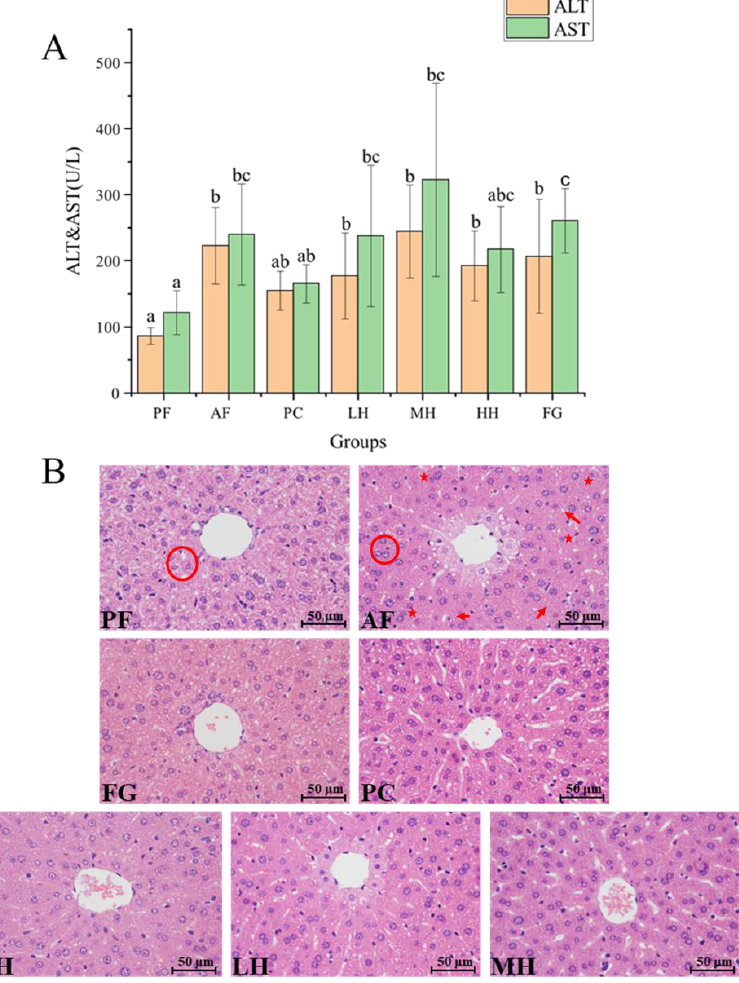
Figure 1. ( A ) Serum alanine aminotransferase (ALT) and aspartate aminotransferase (AST) levels of mice in each group. Different letters a, b, and c represent the significant differences between groups ( p < 0.05). ( B ) Liver pathology sections stained with hematoxylin and eosin (HE × 400). Highlights are the disappearance of a cell gap (encircled), inflammation (stars), and hepatic steatosis (bold arrows). Note: PF represents the pair – fed control group. AF represents the alcohol – fed model group. PC represents the positive control group. LH represents the low – dose citrus honey group. MH represents the medium – dose citrus honey group. HH represents the high – dose citrus honey group. FG represents the fructose syrup group.